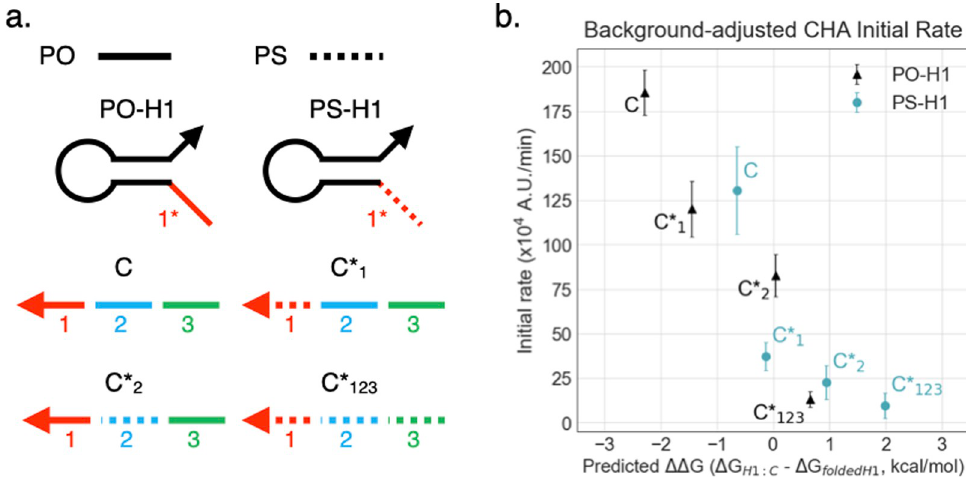
Fig 6. Introducing PS backbones to select domains in LT-CHA. (a) Modified parts used in LT-CHA circuit. (b) Observed initial rate of LT-CHA plotted against predicted change in free energy using modified-domain 1 hairpins with various modified versions of the catalyst strand. PO-H1 = hairpin 1 with only phosphodiester backbones. PS-H1 = hairpin 1 with PS modifications on domain 1 � . C � n = catalyst strand with PS on domain(s)